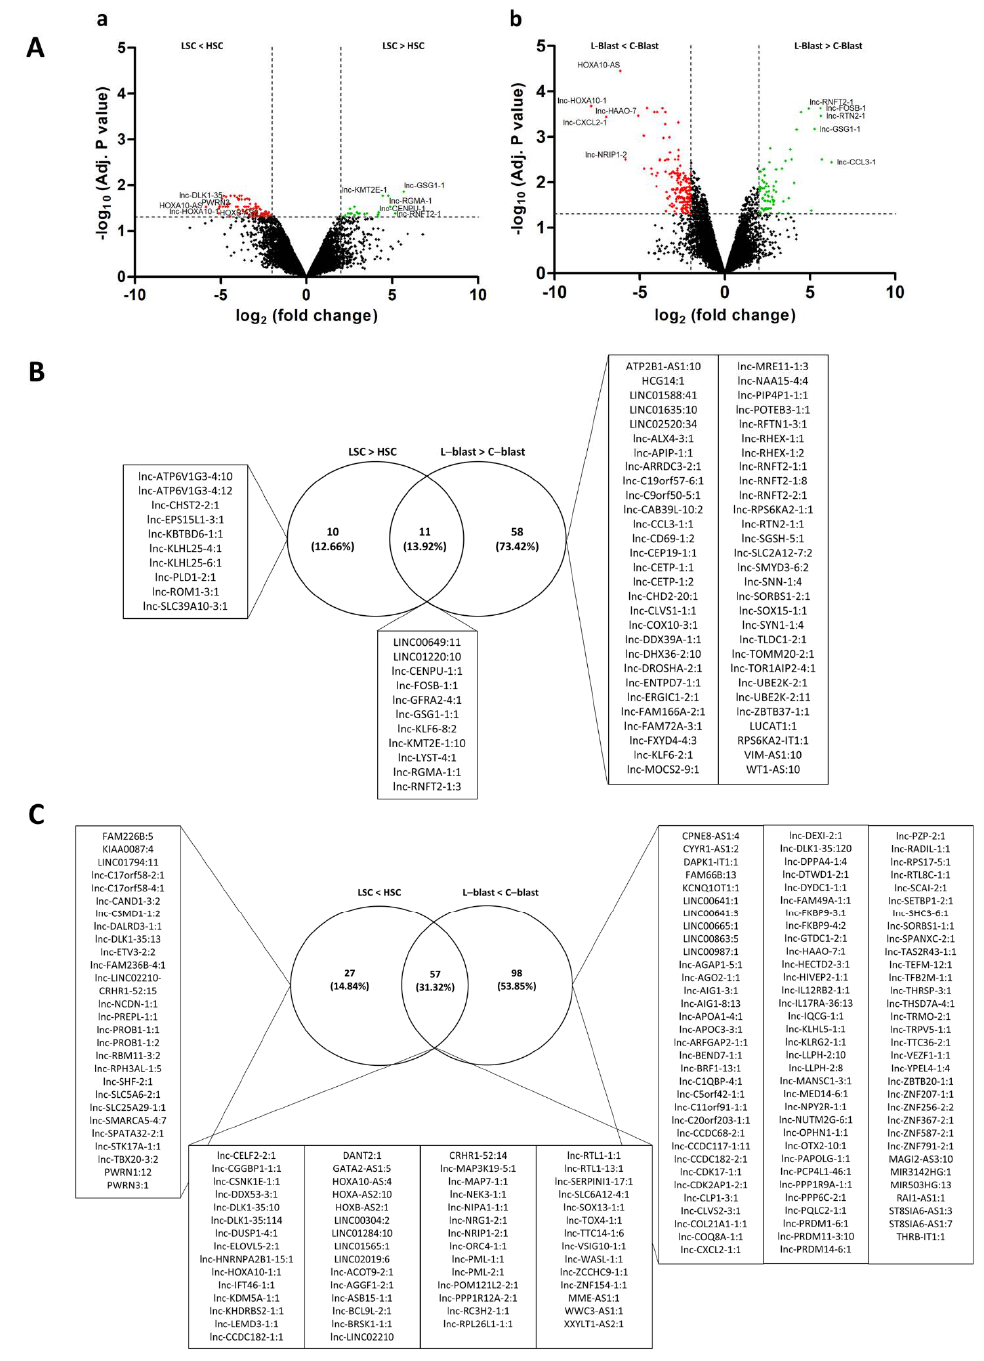
Figure 3. ( A ) lncRNAs are plotted in volcano plots as log2 FC values against − log10 adj. p values. ( a ) Volcano plot of the LSC and HSC comparison. ( b ) Volcano plot of the L-blast and C-blast comparison. Thresholds |log2FC| > 2 and log10 adj. p ≤ 0.05 are shown as dashed lines, and significantly up- and downregulated lncRNAs are highlighted in green and red, respectively. Top 5 up- and downregulated DE-lncRNAs are indicated. ( B ) Venn diagram of all upregulated lncRNAs (|logFC| ≥ 2, Adj. p value < 0.05) in both leukemic fractions compared to their normal counterparts. ( C ) Venn diagram of all downregulated lncRNAs (|logFC| ≥ 2, Adj. p value < 0.05) in both leukemic fractions compared to their normal